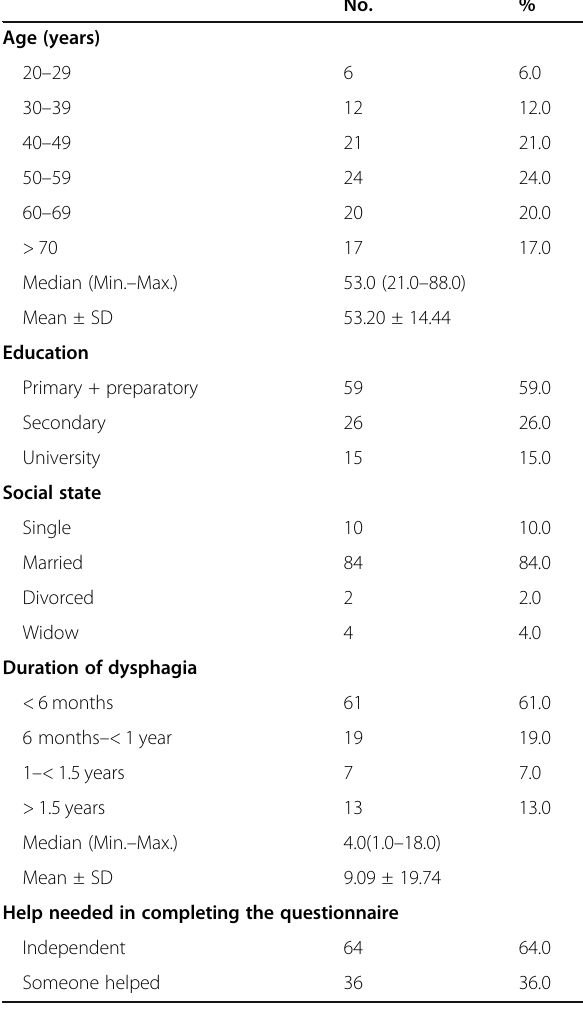
Table 1 Demographic characteristics ( n = 100)